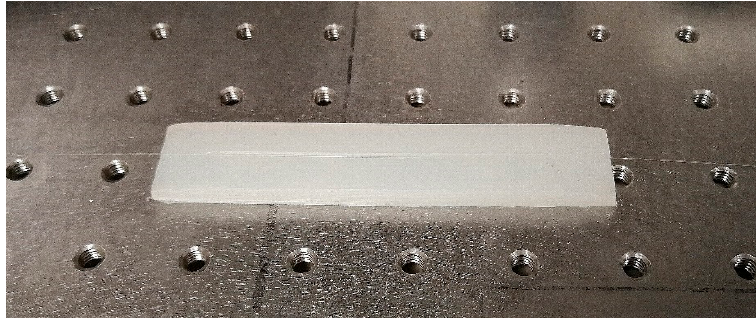
Figure 6. C-Shape optical fiber with FBG inscribed affixed to a nylon block with a V-groove.